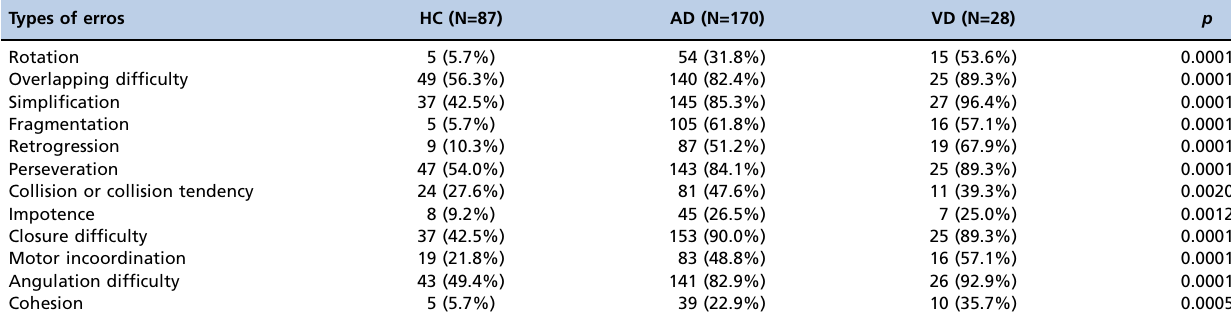
Table 3 - Frequencies, percentages and p-values for types of